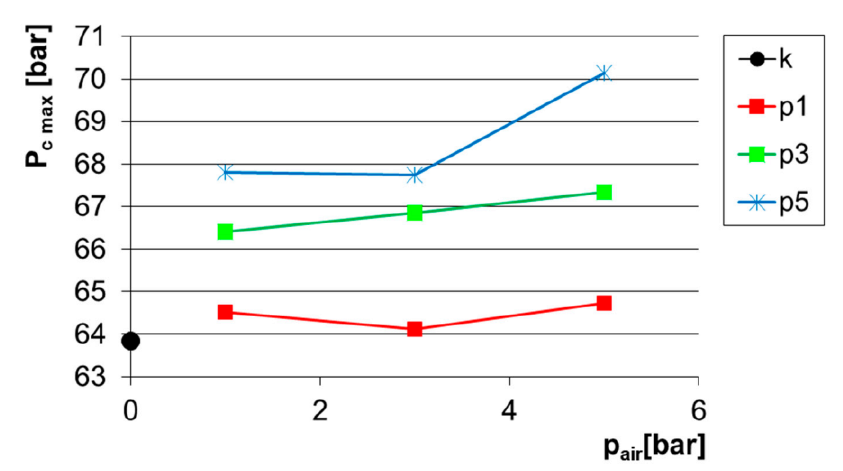
Figure 8. Influence of air supply pressure p air on maximum combustion pressure P c max